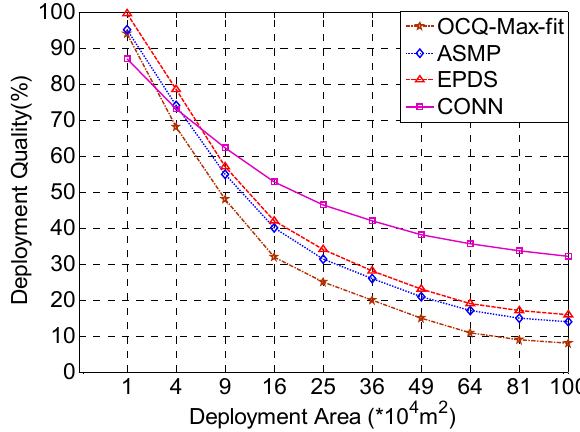
Figure 5. The CONN algorithm is compared with the ASMP, EPDS, and OCQ-Max-fit algorithms in terms of the deployment quality under different deployment environments.